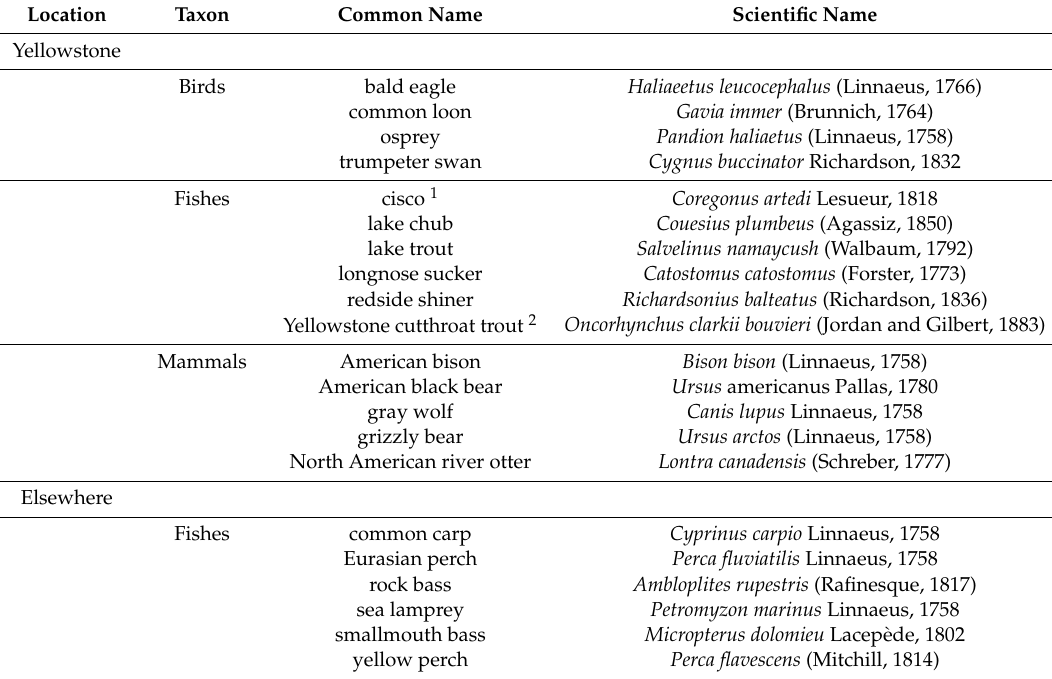
Table A1. Common and scientific names of birds, fishes, and mammals referred to in text for locations within Yellowstone National Park and